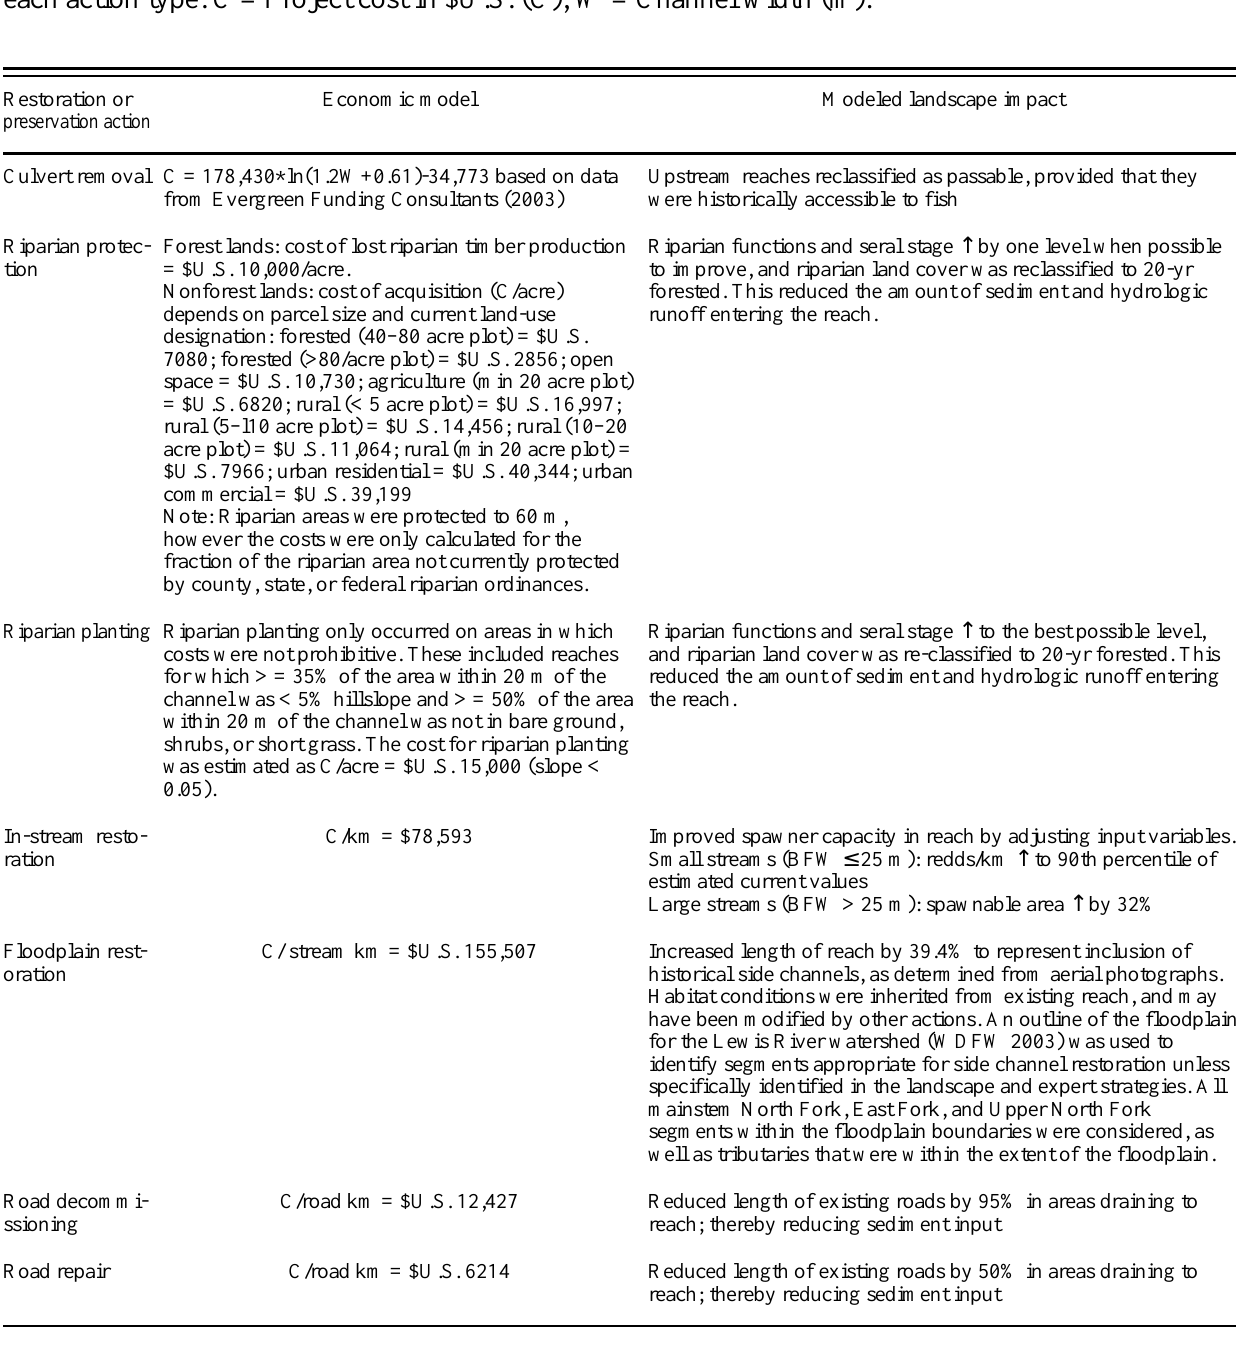
Table 3. Restoration action and economic models. Possible restoration and preservation actions are identified in the first column. The landscape impact column describes how the action was implemented on the landscape in our modeling framework. A description of how each modeled action was translated into EDT input data is found in the Appendix. The economic model column describes the cost estimated for each action type. C = Project cost in $U.S. (C); W = Channel width